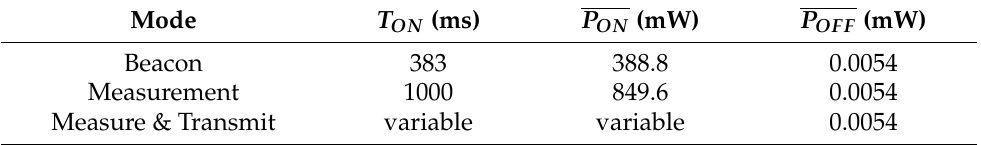
Table 3. Sensor Node: average power consumptions and time durations for the different modes. Mode T ON (ms) P ON (mW)